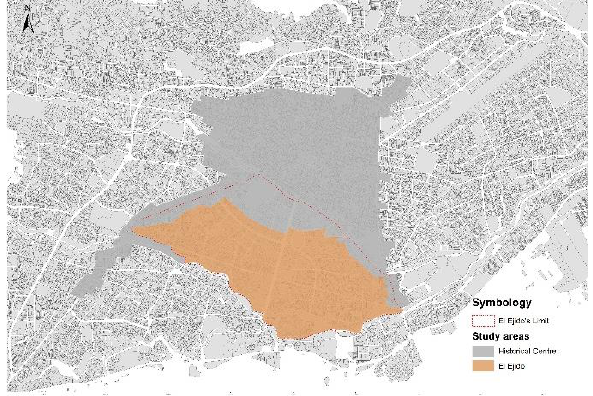
Figure 3. Location of El Ejido and its spatial relation with the Historical City Center. Source: authors.